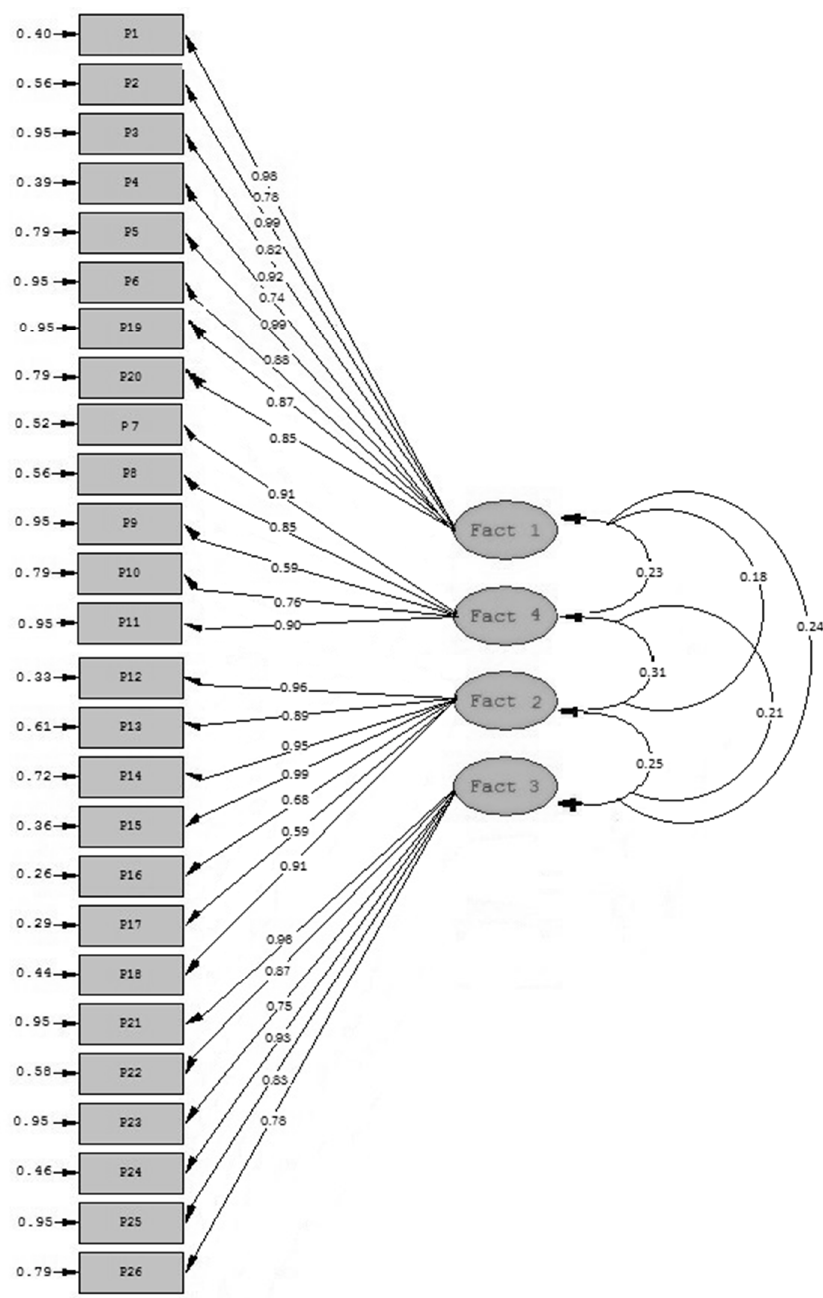
Figure 1. Schematic (path graph) of Questionnaire of Psychological and Learning Environments in adaptive Contexts (QPLEC).